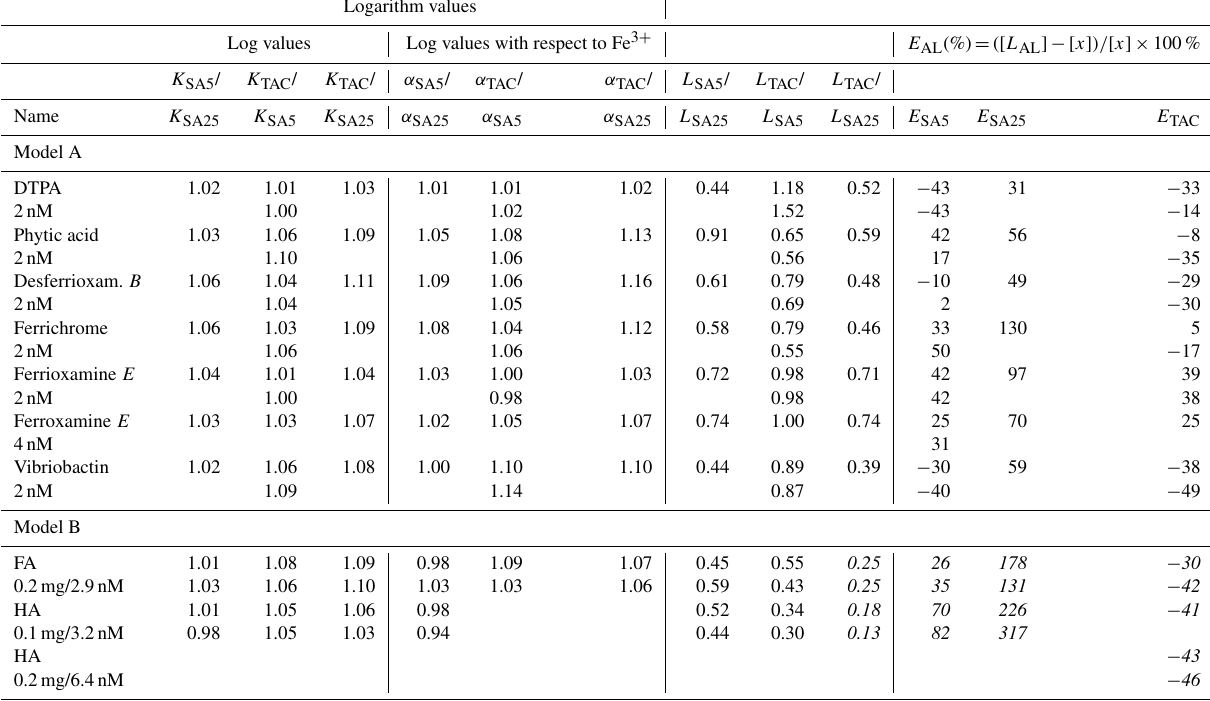
Table 3. The differences between the results in Table 3 of the three applications, ratios or difference in concentration are given. Added model ligand concentrations are given in column 1. The far right column contains the percentual deviation from the added ligand concentration as E (%) = (([ L AL ]−[ x ] )/ [ x ] ) × 100, with [ L AL ] as the result of the applied ligand method and [ x ] as the added concentration of the model ligand being 2, 4, 2.9, 3.2 or 6.4nM (as indicated in the first column at the left side under the name of the model ligand). log K is used for log K cond with respect to Fe 3 + . Data containing the ligand concentration are from the model ligands added at a concentration of 2nM and thus exclude HA and FA. For these we used the ligand site concentrations of 2.92 and 6.4nMEqFe for 0.2mg of added fulvic and humic acids from Sukekava et al. (2018) and Laglera and van den Berg (2009). Since humic acids are not discrete ligands, the estimate % E is in